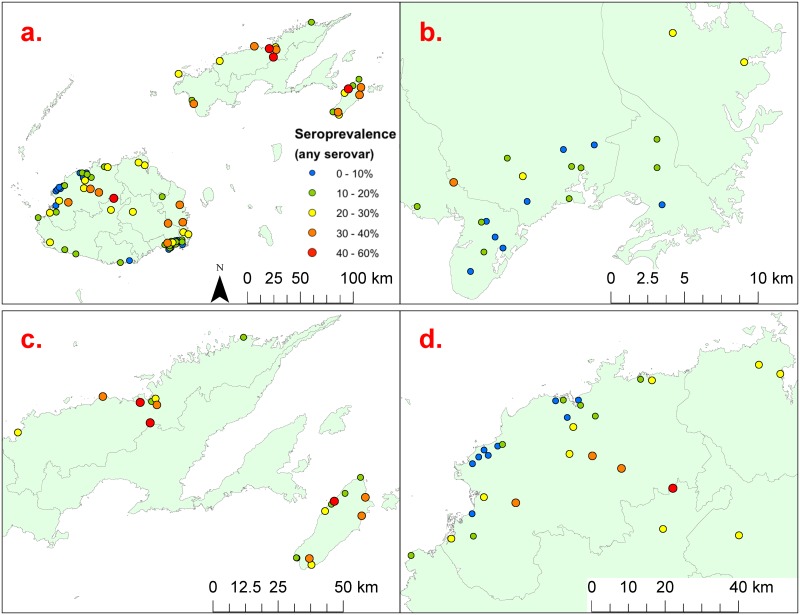
Community-level seroprevalence at the 81 communities included in the study; a) prevalence varied from 0% to 60%; b) enlargement of the Suva area in eastern Viti Levu; c) enlargement of Taveuni and eastern Vanua Levu; and d) enlargement of northwestern Viti Levu including Ba.